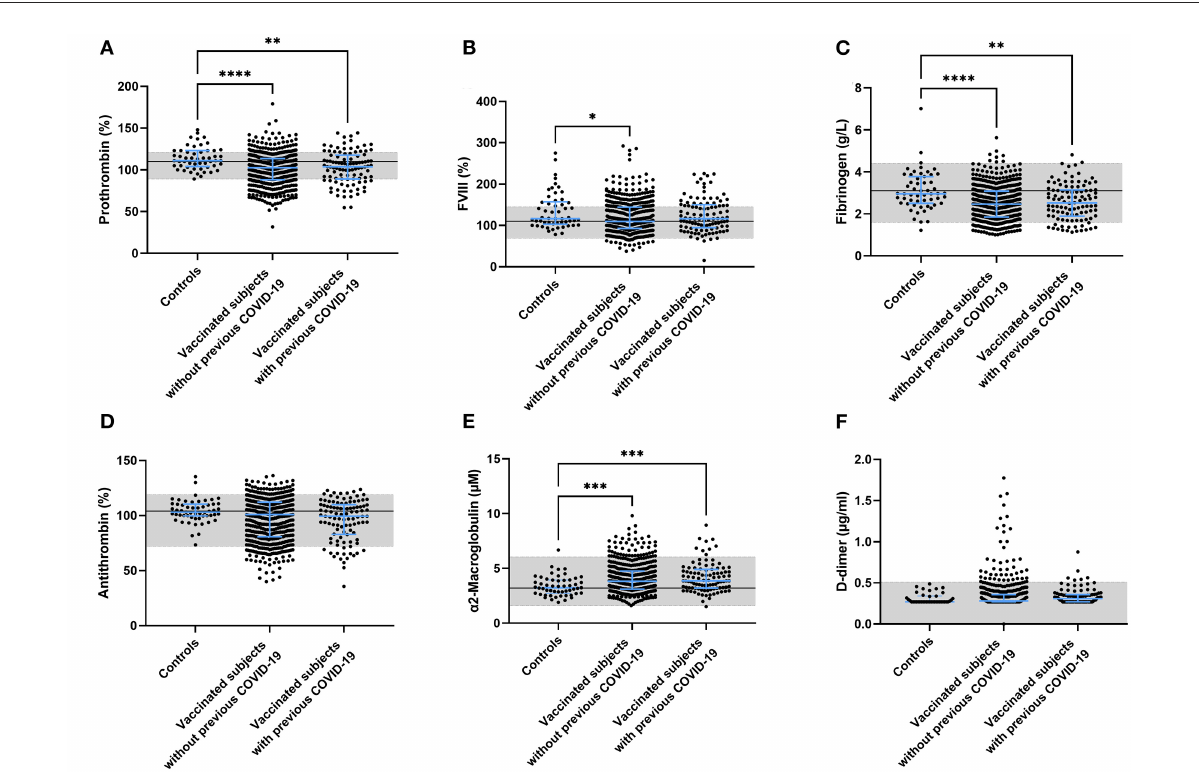
FIGURE2 Coagulation factor levels in controls and subjects vaccinated with ChAdOx1-S with and without prior COVID-19 infection. Plasma levels of prothrombin (A) , FVIII (B) , fibrinogen (C) , antithrombin (D) , α 2-macroglobulin (E) and D-dimer (F) were quantified. Reference values for each test are indicated as the gray area in the dot plot. Differences between the groups were analyzed by ANOVA or Kruskal-Wallis analysis, depending on the distribution of the data. P -values below 0.05, 0.01, 0.001, and 0.0001 were marked as * , ** , *** , and **** ,